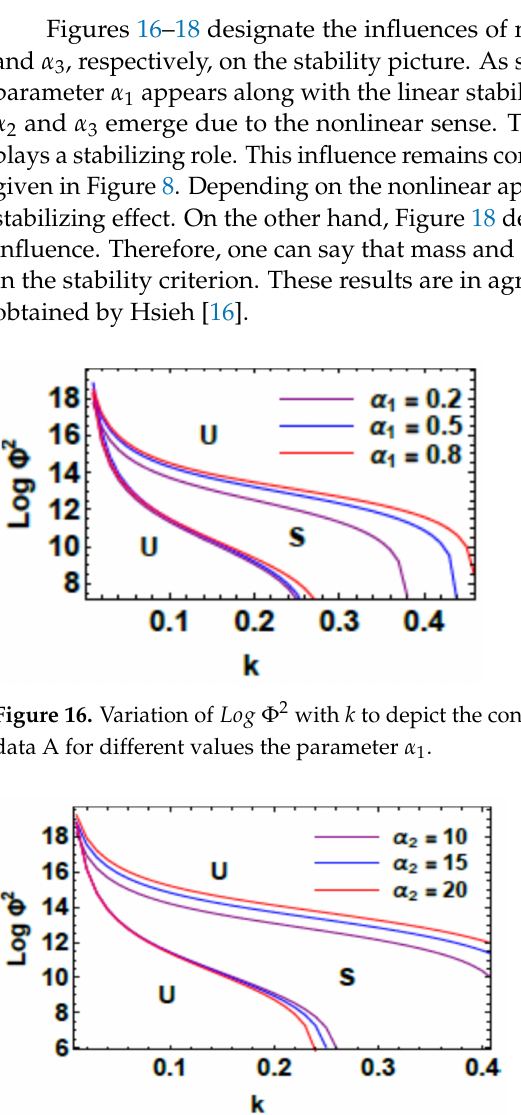
Figure 17. Variation of Log Φ 2 with k to depict the contribution of Equations (53) and (54) along with data A for different values the parameter α 2